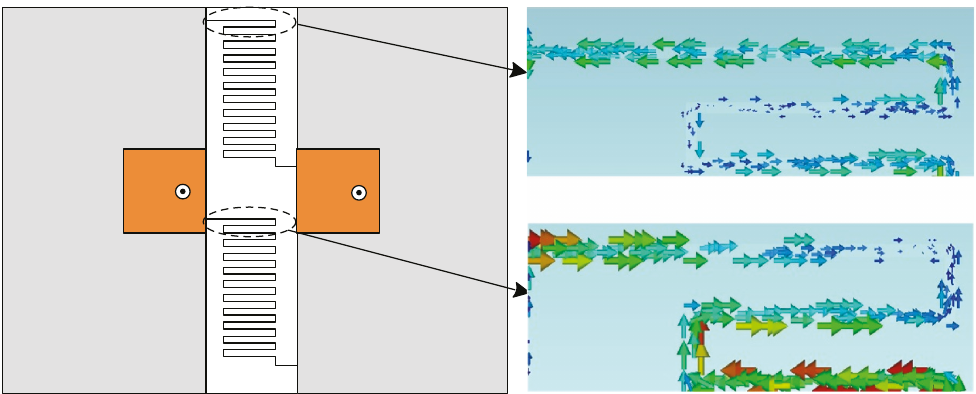
Figure 6: The antenna array with the ML in the second con fi guration and the simulated current density vectors on the ML.